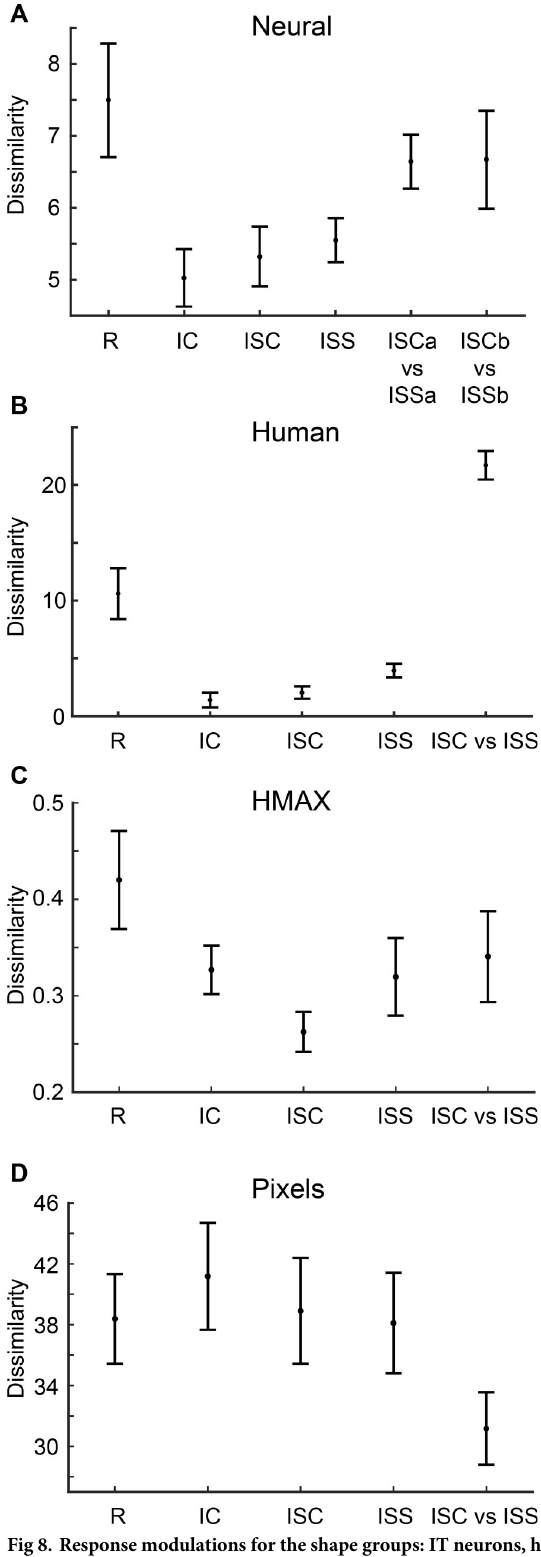
Fig 8. Response modulations for the shape groups: IT neurons, human judgements, HMAX and pixel-based dissimilarities. (A) Mean response modulations of IT neurons for the shape groups R, IC, ISC, ISS, “ISCa vs ISSa” and